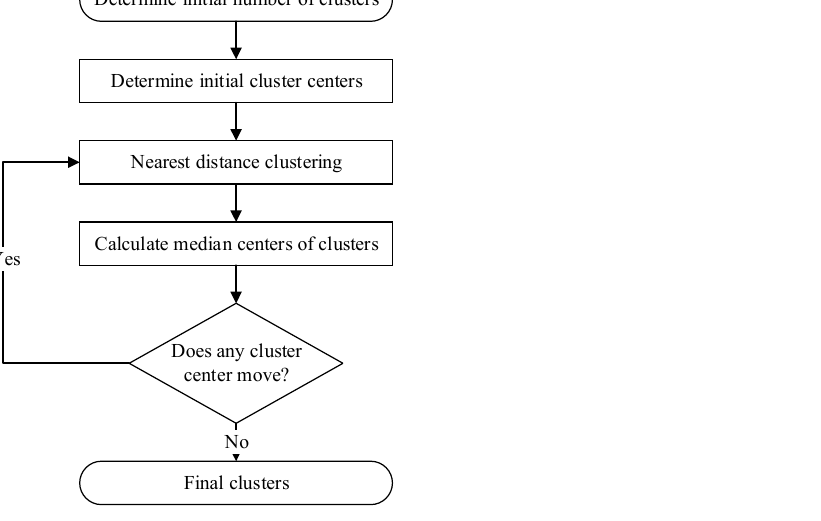
Figure 2. A K-Median-Centers algorithm for the implementation of the STICA method in this study.